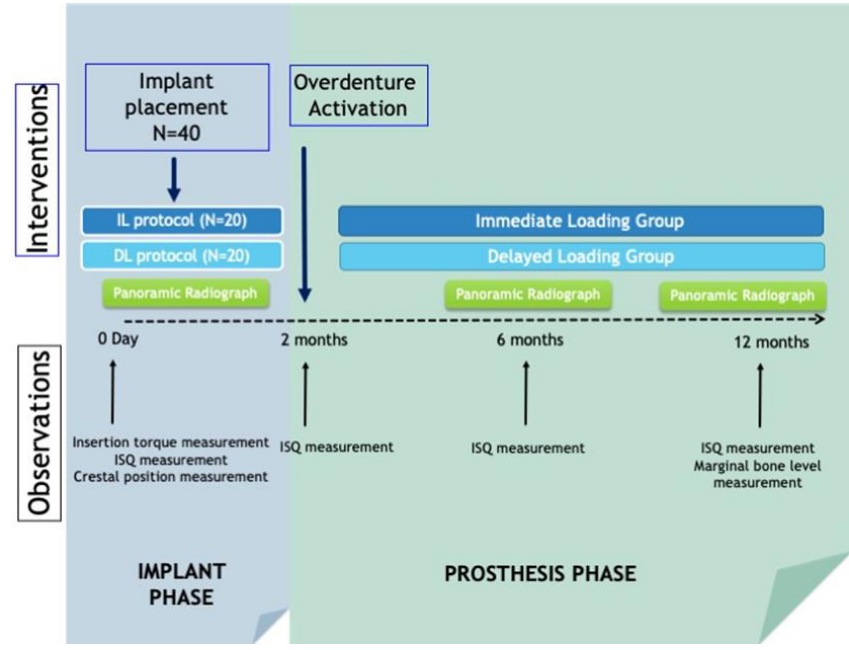
Figure 1. Diagram of the observations and interventions scheduled in the study.